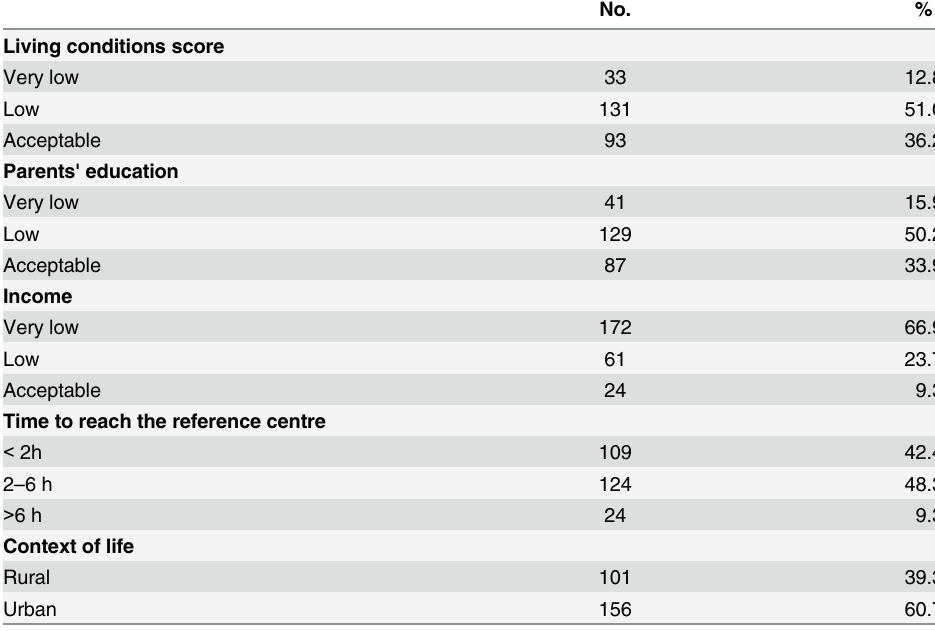
Table 2. The social profile of the cohort of 257 CKD paediatric patients.